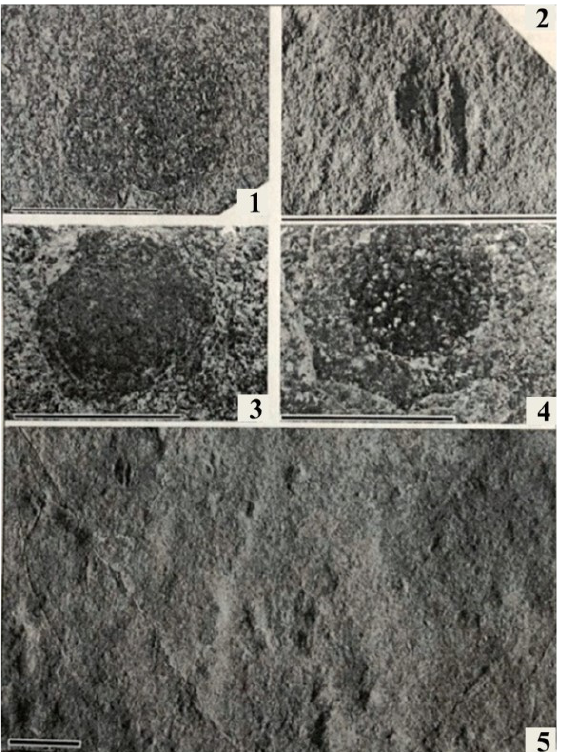
Fig. 4. 1-4- Problematical remains of Chuaria sp. and Aspidella-like imprint from the Tsagaan-Olom Formation of the Zavkhan phosphate basin, western Mongolia (modified after Ragozina et al., 2010). 5- Surface of fossiliferous layer, Tsagaan-Olom phosphate -bearing Formation (Dorjnamjaa et al., 2018).